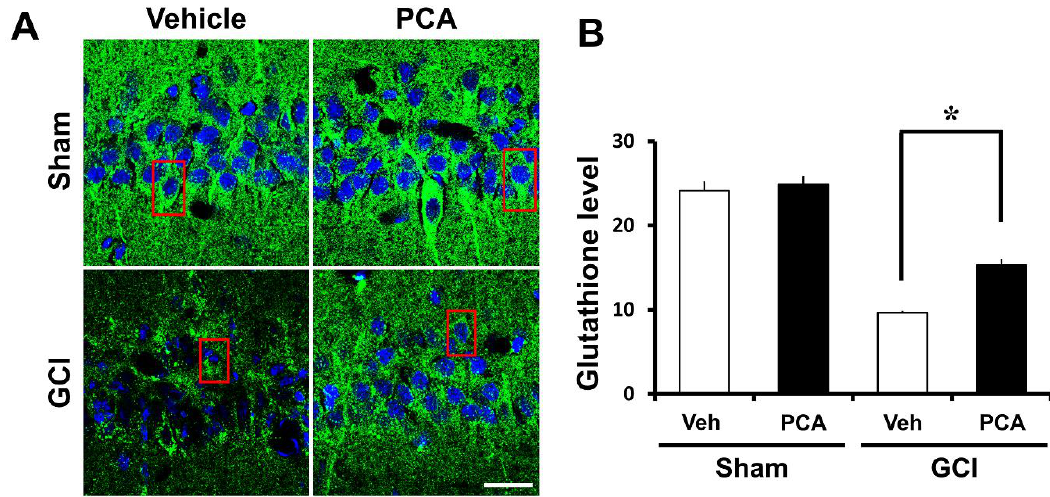
Figure 6. PCA administration rescues glutathione depletion after ischemia. This image displays gaps in glutathione (GSH) levels. ( A ) The sham-operated group include a mostly plentiful glutathione grade in the hippocampus. This image indicates GS-NEM (+) neurons of four groups; sham-vehicle ( n = 3), sham-PCA ( n = 3), ischemia-vehicle ( n = 3), and ischemia-PCA ( n = 3). Oral injection of PCA for one week after global ischemia improved GS-NEM fluorescent intensity in the CA1 region more than the saline- treated group. Scale bar = 20 μm. ( B ) The bar graph shows that the evaluation of GS-NEM fluorescence intensity in the CA1 region of four groups. The fluorescence intensity is significantly different between the vehicle and PCA-treated group. Data reflect the mean ± S.E.M., n = 3 from each sham group and the ischemia group. * Significantly different from the vehicle-treated group, p < 0.05.